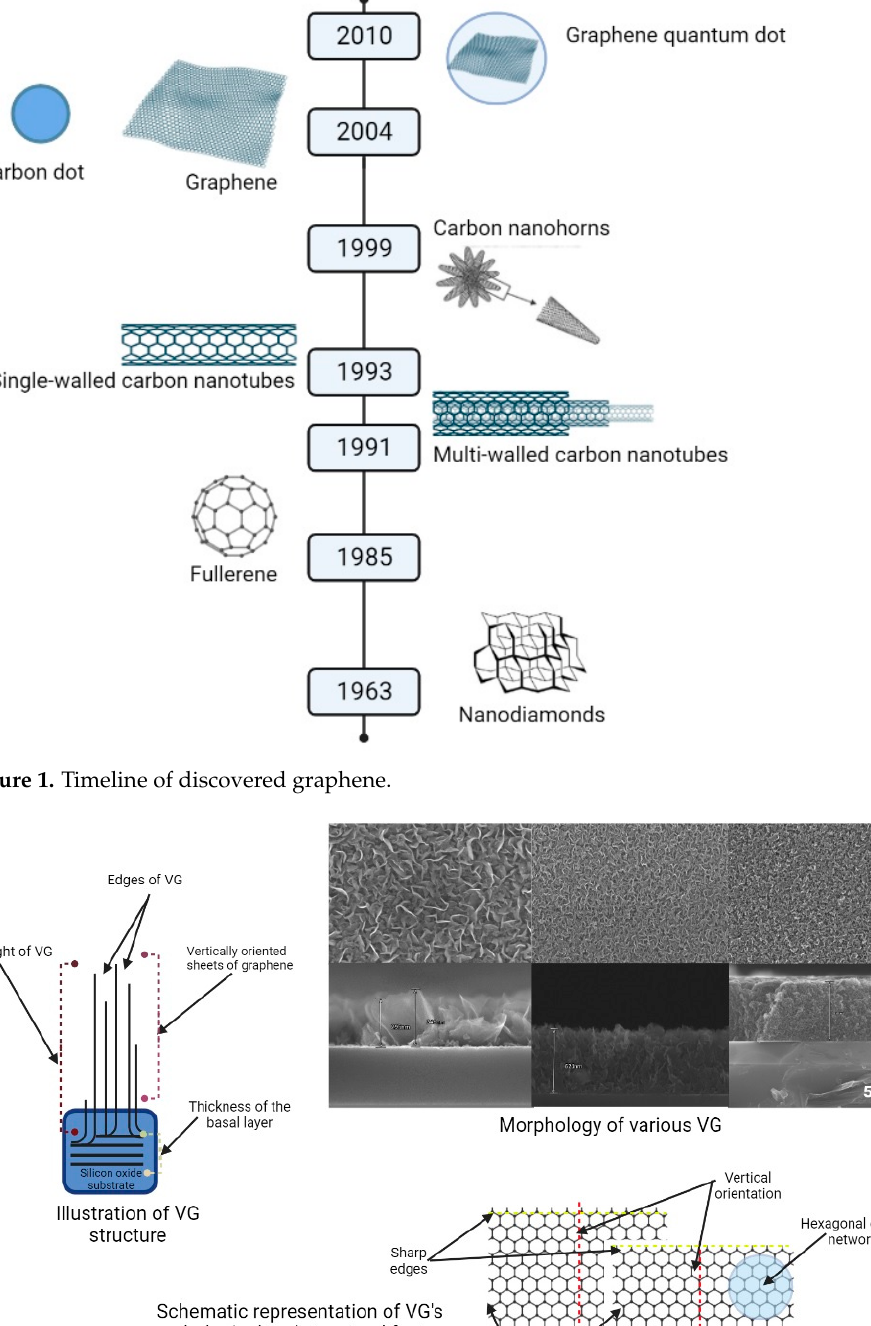
Figure 3. Graphical interpretation of vertical graphene growth methods and potential applications in the biomedical domain .